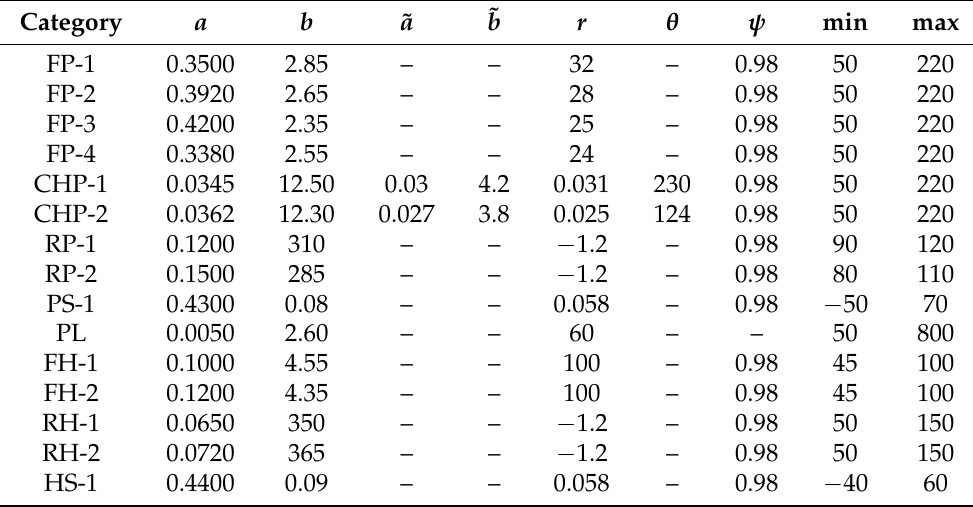
Figure 2. Structure of the tested seaport integrated energy system. Table 1. Operation parameters of the tested